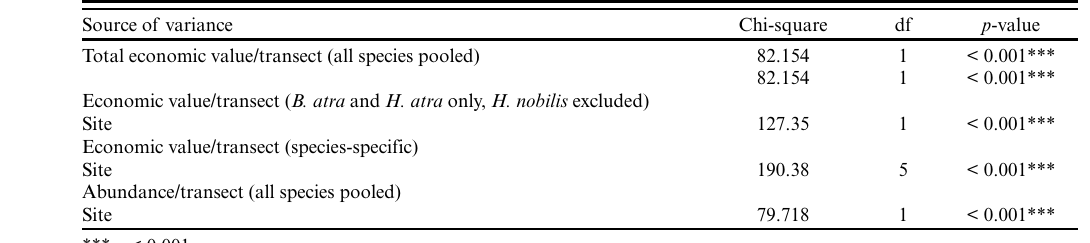
Table 3 . Summary of nonparametric analysis of variance (ANOVA) models (Kruskal-Wallis) comparing economic values of sea cucumbers between Mayotte and Zanzibar.